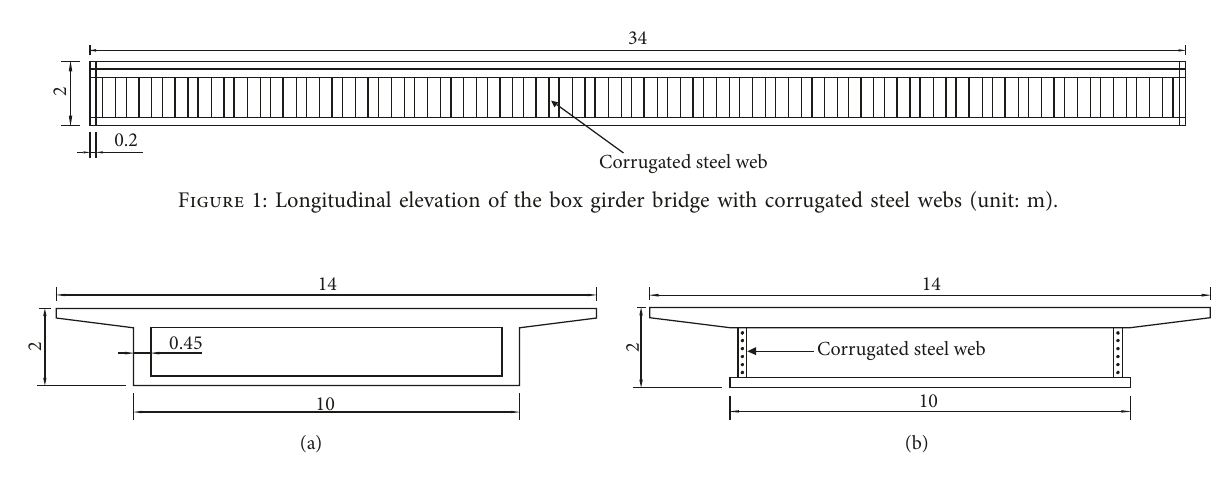
Figure 2: Cross section of the main girder (unit: m). (a) Concrete box girder. (b) Box girder with corrugated steel webs. Table 1: Basic material